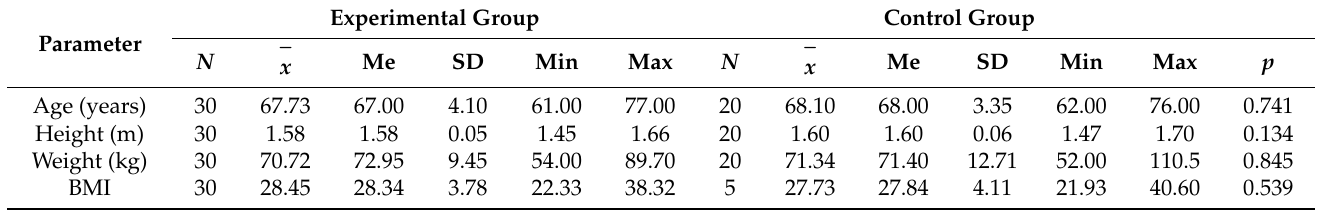
Table 1. Sample characteristics.